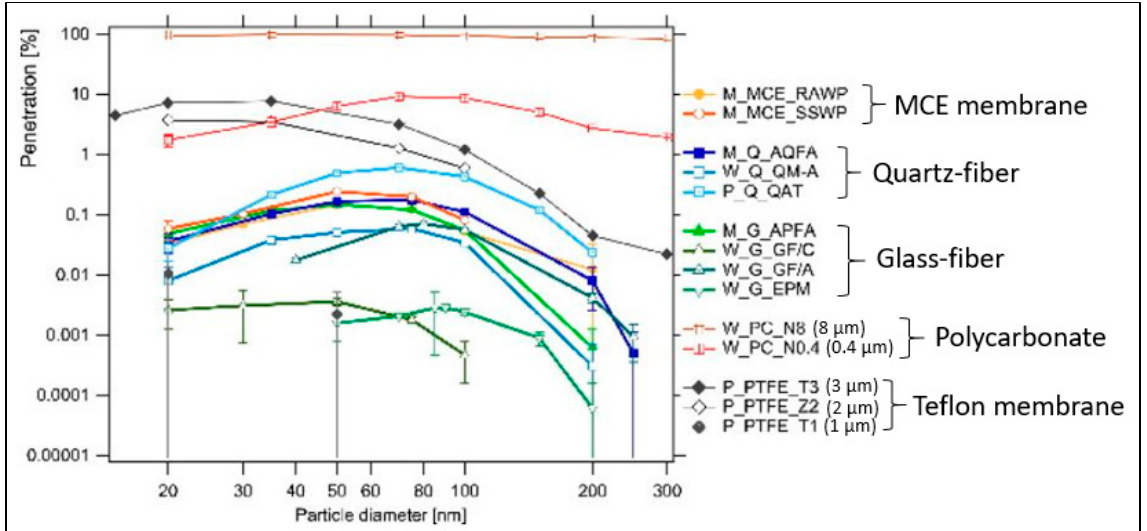
Figure 2. Size-resolved penetration of submicron particles by mixed cellulose esters (MCE), quartz, glass fiber, polycarbonate (PC, 0.4 and 8 µm), and Teflon (Zefluor 2 µm and Teflo 1 and 3 µm) at a face velocity of 40 cm/s [106]. Reprinted by permission of Taylor & Francis Ltd. on behalf of the American Association for Aerosol Research.